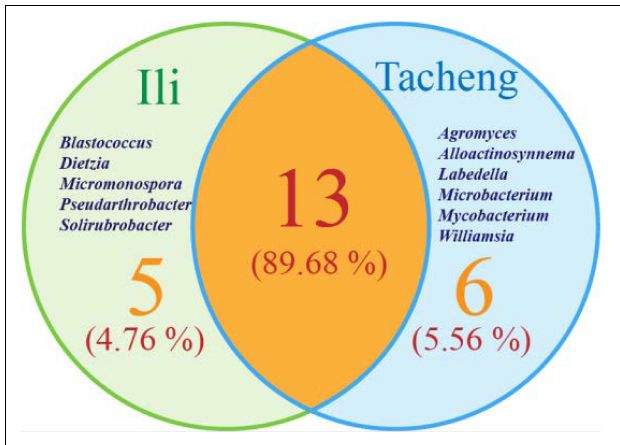
FIGURE 5 | Venn diagram of endophytic actinomycetes in genera level from the T. roseus Schipcz. collected in two different geographical